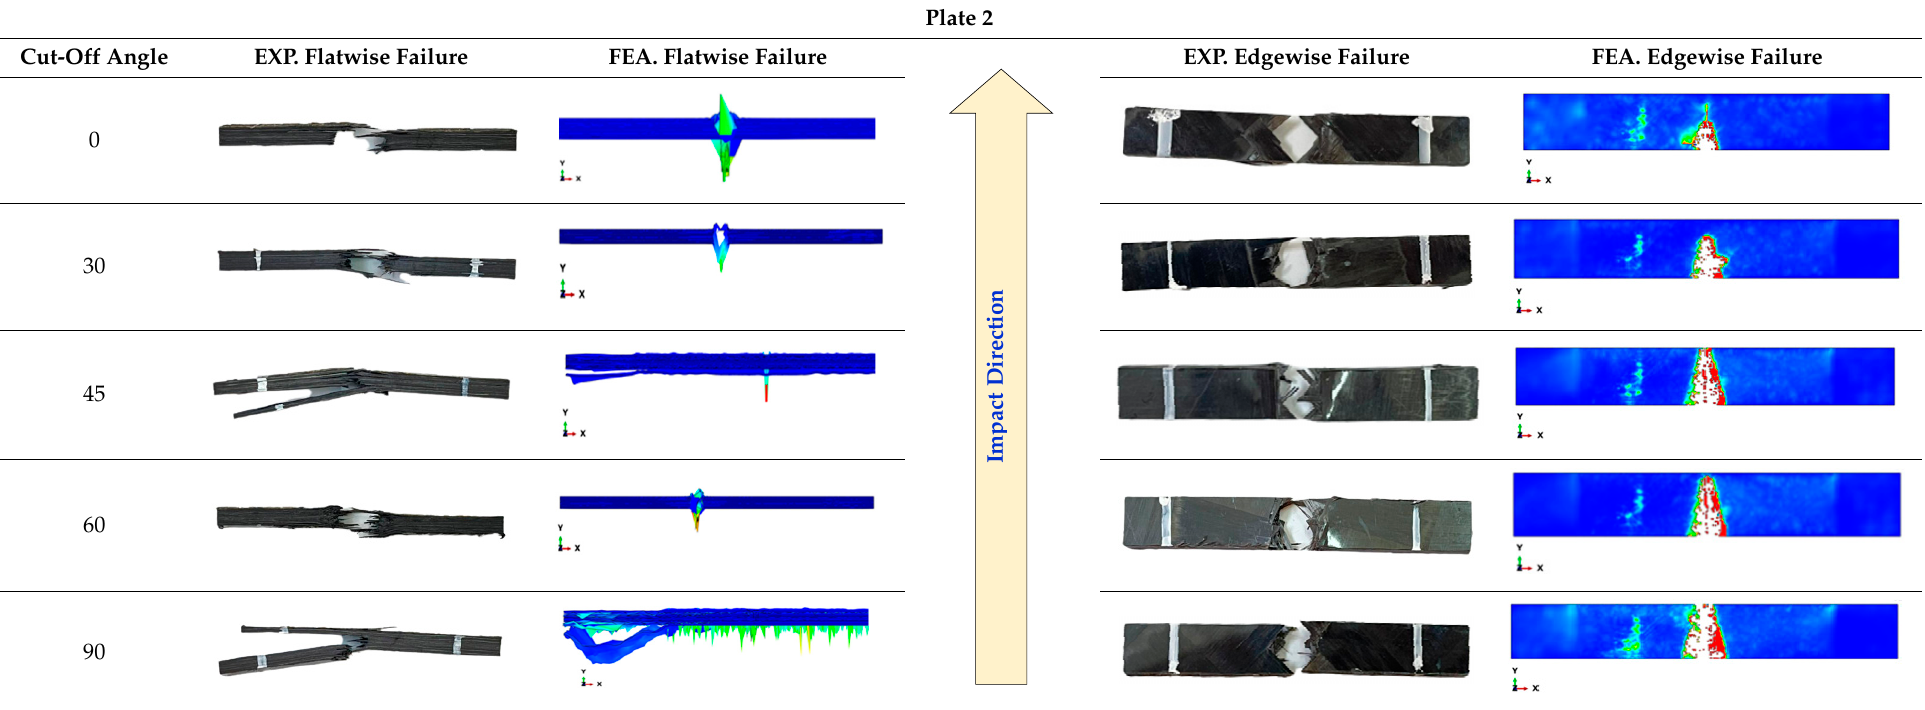
Table 4. Failure modes of Plate 2 under Charpy impact test conditions.